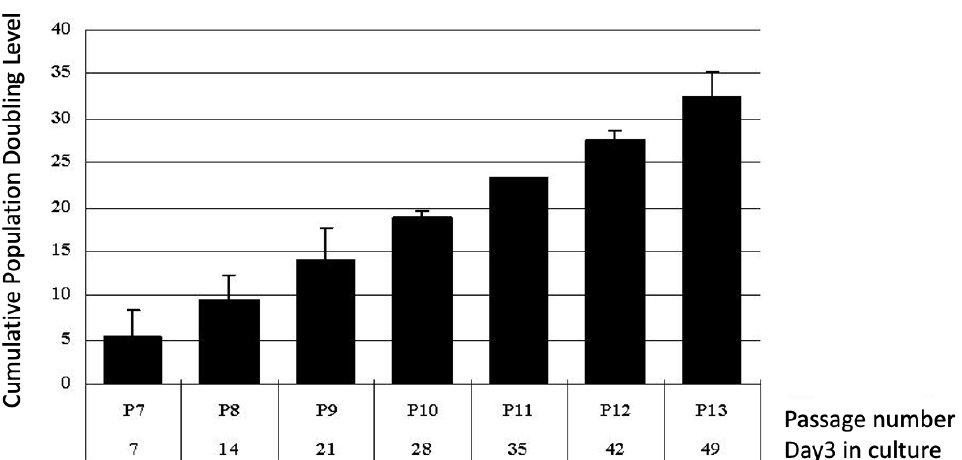
Figure 3. Average accumulative population doubling from three cases was shown. The average population doubling